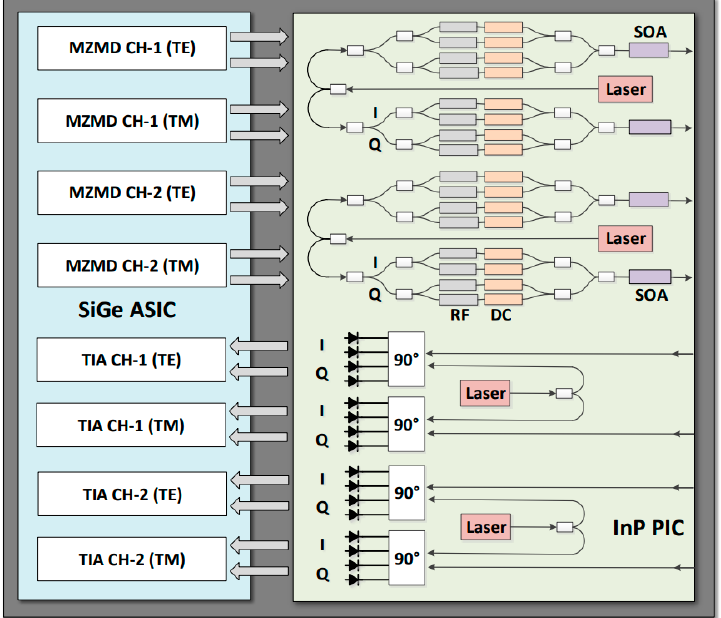
Figure 14. Schematic of transceiver integration scheme based on coherent detection; MZMD: Mach Zehnder modulator driver; TE: transverse-electric; TM: transverse-magnetic; TIA: trans- impedance amplifier; RF: radio-frequency; DC: direct current; InP: Indium phosphide; PIC: pho- tonic integrated circuit; SOA: semiconductor optical amplifier; Ch_1: the first channel; (From